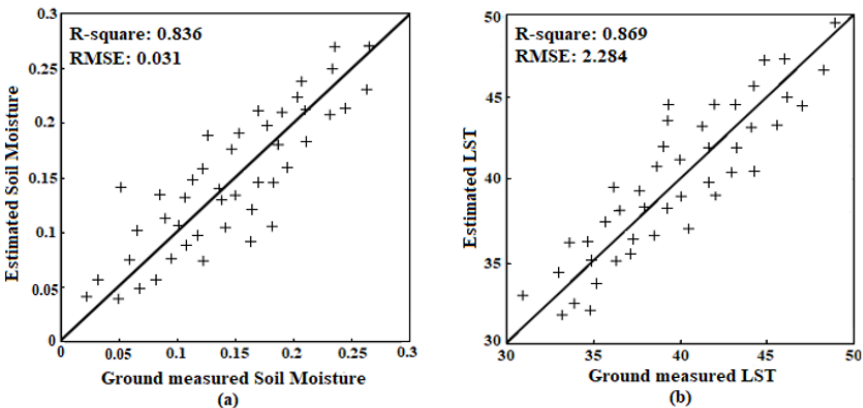
Figure 8. Comparison between measured and estimated parameters using POVI in nonlinear rela- tionship: ( a ) Soil moisture (%), ( b ) Land surface temperature (°C).